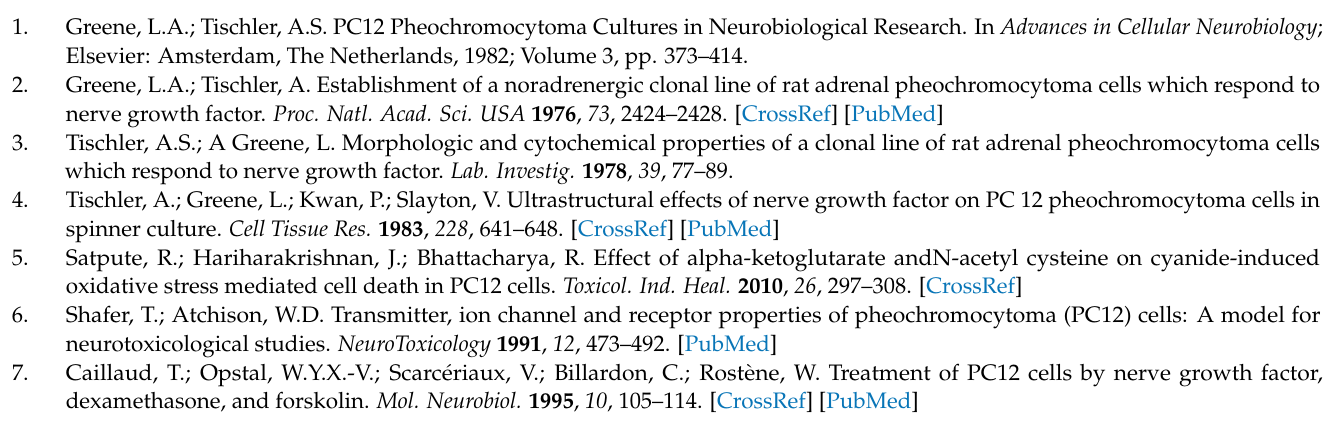
Figure A4. Graphical representation of the burst-firing (top left), reverse burst firing (top right), Thomas (bottom left), and 7-Hz burst (bottom right) patterns.